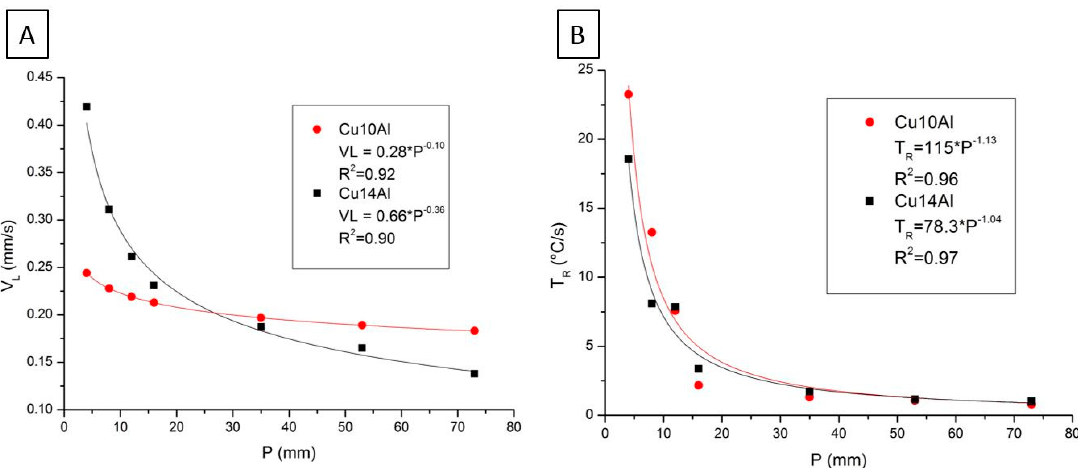
Figure 4. Solidification thermal parameters: ( A ) correlation between tip growth rate (V L ) and distance from heat extraction surface (P); and ( B ) correlation between cooling rate (T R ) and distance from heat extraction surface (P). The error bars represent the standard deviation of the measurements obtained.